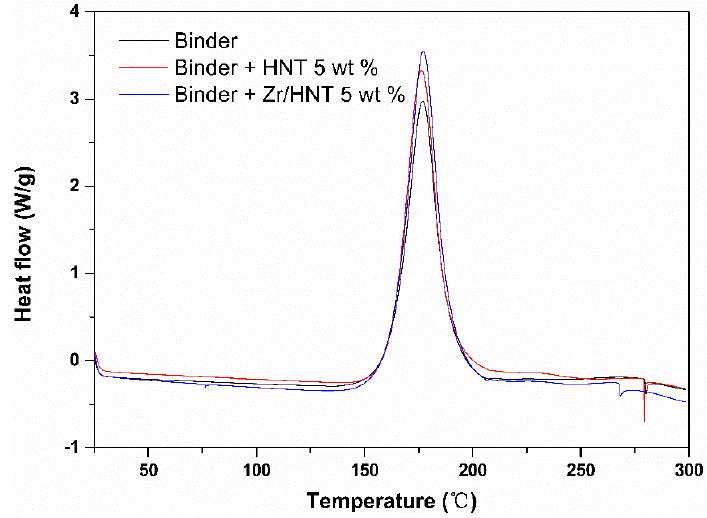
Figure 6. DSC profile of the epoxy resin and the epoxy composites. Table 1. Curing temperature ( T cure ) of the composites calculated from T peak and T onset .